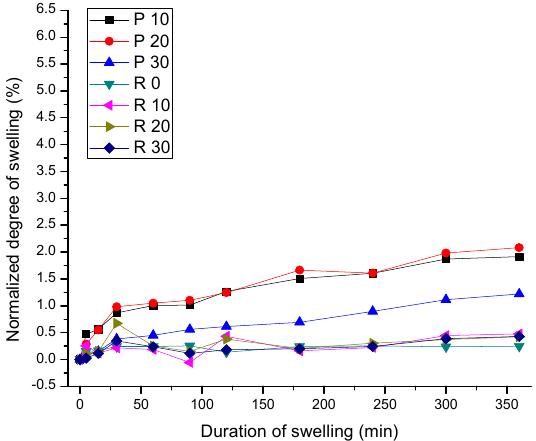
Figure 10. Normalized degree of swelling of the modified photopolymer printing plate samples in Polywash.